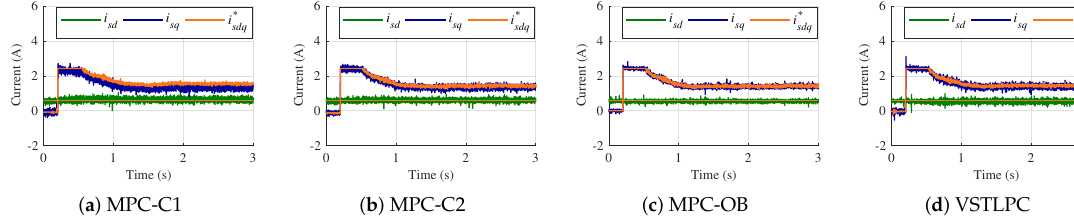
Figure 8. Evolution of d – q currents and their references for each controller in a speed step test from 0 rpm to 500 rpm with a load torque of the 60%.